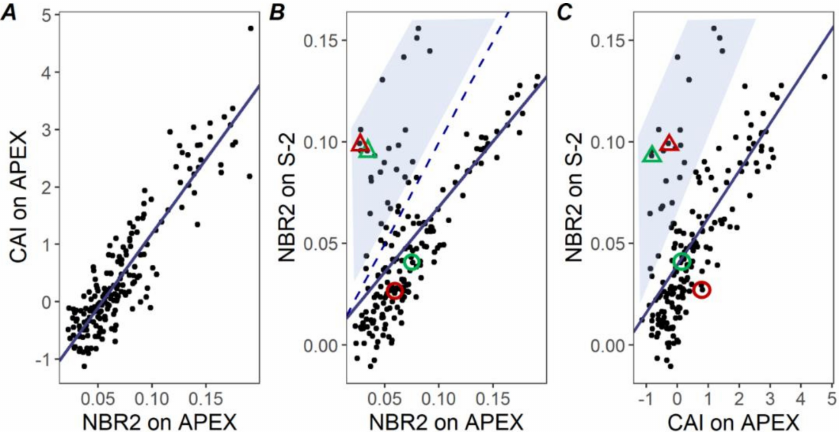
Figure 15. Relationships between the Cellulose Absorption Index (CAI) and the Normalized Burn Ratio 2 (NBR2) calculated on airborne hyperspectral data (APEX image from 2 September 2018) and on satellite multispectral data (S-2 image from 24 August 2018) on a set of 188 fields randomly selected in the Belgian loam belt ( A – C ). The dashed line in ( B ) represents the 1:1 line. The blue lines represent the linear regression (Table 5). For the explication of the blue shaded area, please see Section 3.3. The red symbols represent fields from Figure 16A and the green symbols from Figure